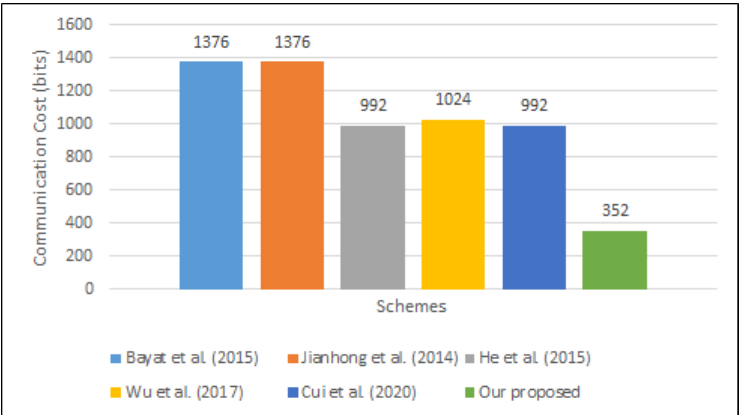
Figure 7. Cost of communication